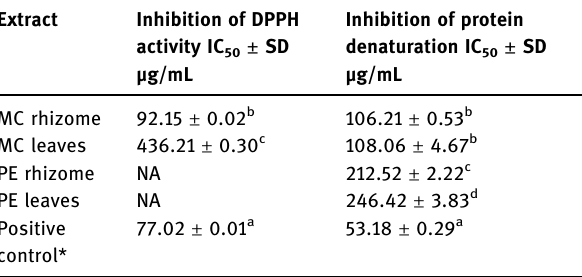
Table 2: IC 50 values of in vitro antioxidant and anti - protein dena - turation activities of C. longa rhizome and leaves